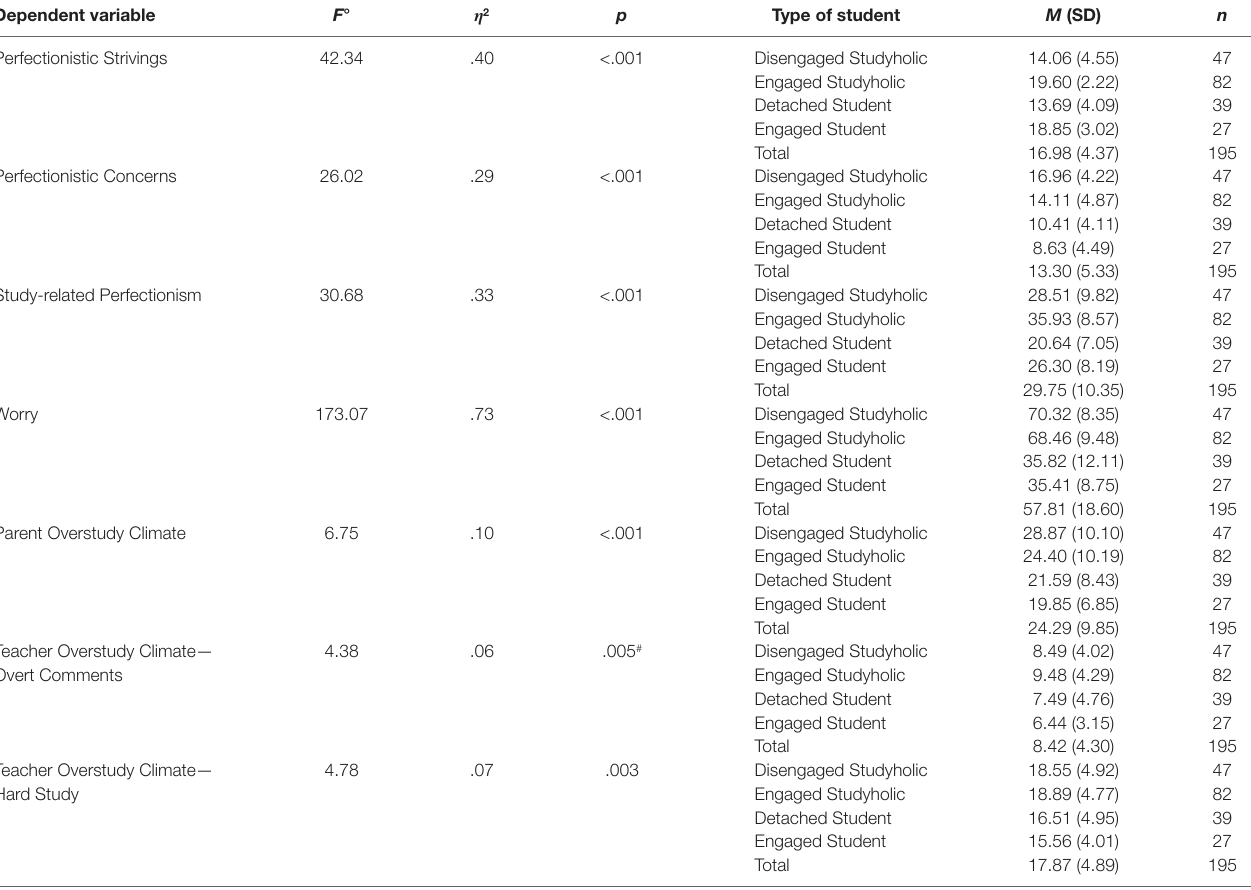
TABLE 6 | Means (SDs) and follow-up ANOVAs conducted after the MANOVA of antecedents by type of